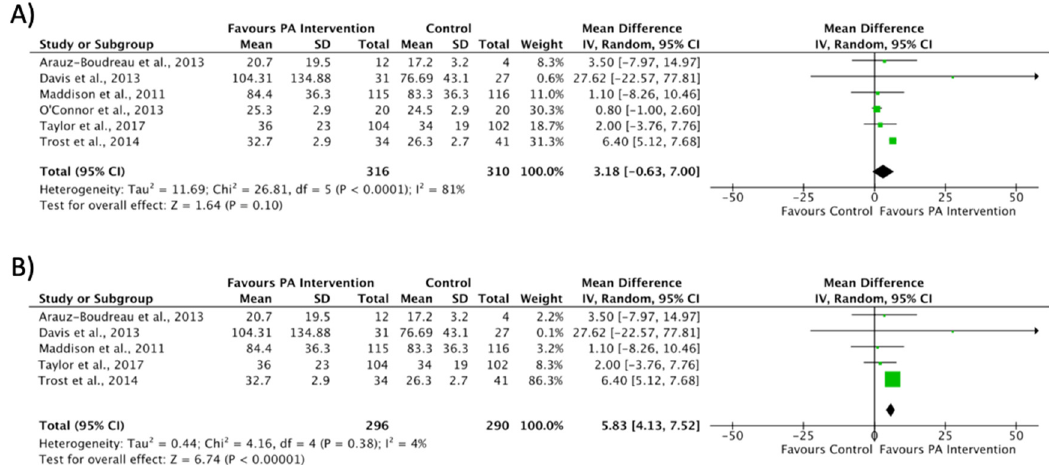
Figure 4. Effect interventions on increased moderate to vigorous physical activity time in minutes. ( A ) Moderate to vigorous physical activity levels forest plot. ( B ) Sensitivity analysis of moderate to vigorous physical activity forest plot (O’Connor et al. [32] not included). CI, confidence interval.